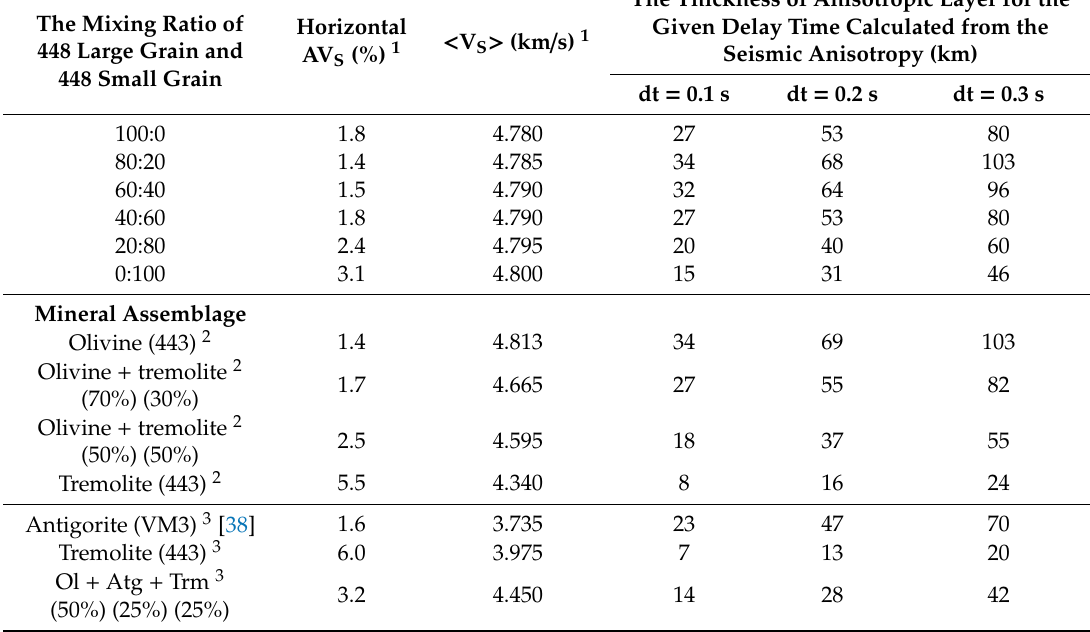
Table 3. Estimated seismic anisotropy and the thickness of the anisotropic layer for the given delay time calculated from the LPOs of the olivine, amphibole, and